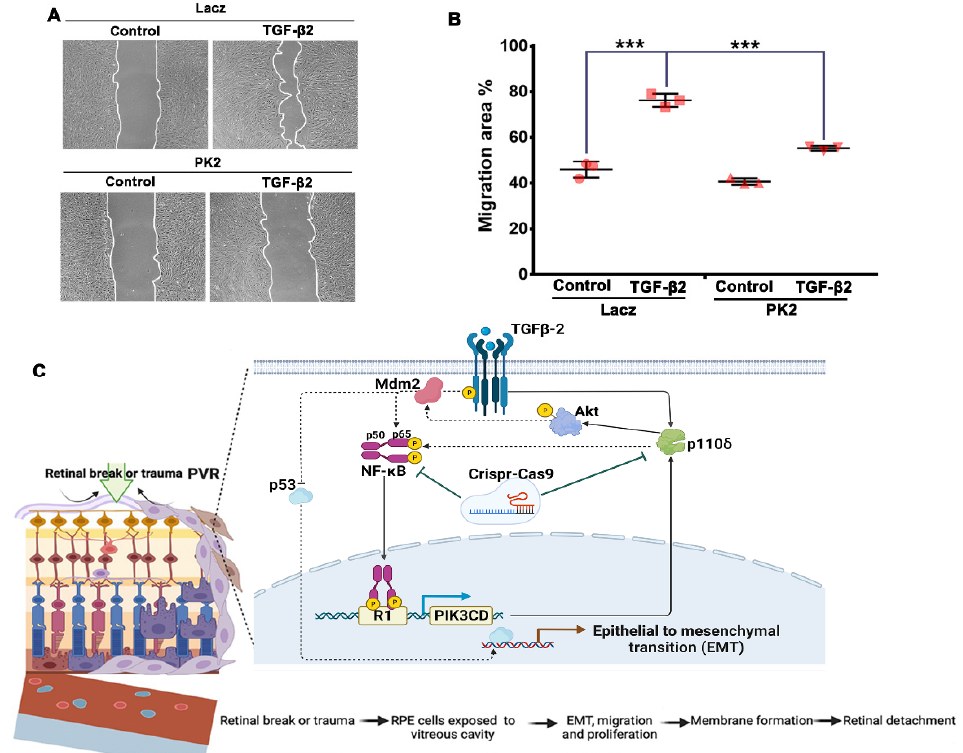
Figure 6. Depletion of PI3K δ blocks TGF- β 2-induced migration of ARPE-19 cells. ( A ). Wells of confluence cells were scratched using 200 µ L pipet tips, washed and photographed at the initial width, followed by treatment with TGF- β 2 (10 ng/mL) for 24 h. Cell images were then taken, and wound areas were analyzed by image J and Adobe Photoshop CS4 software. The data of bar graphs are the mean ± SD of 3 independent experiments. Representative raw data of 3 independent experiments are shown underneath the bar graphs. ( B ). *** denotes p < 0.001 using one-way ANOVA followed by the Tukey HSD post hoc test. ( C ). Diagram of a loop pathway of PI3K δ /Akt/NF κ B/PI3K δ induced